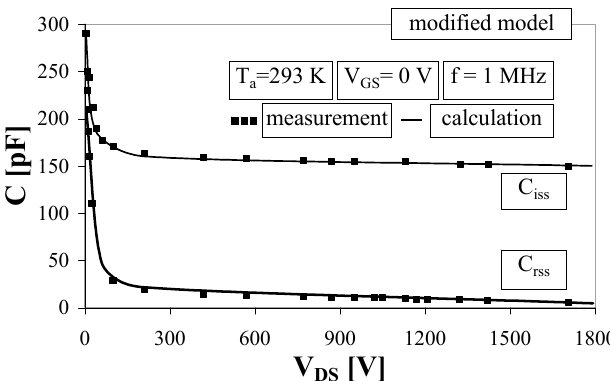
Figure 8. Measured and calculated (modified model) C iss (V DS ) and C rss (V DS ) characteristics of the